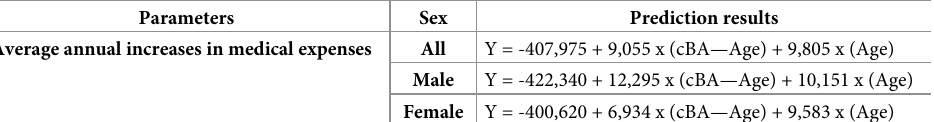
Table 6. Prediction results of average annual increases in medical expenses depending on the differences between cBA and CA.